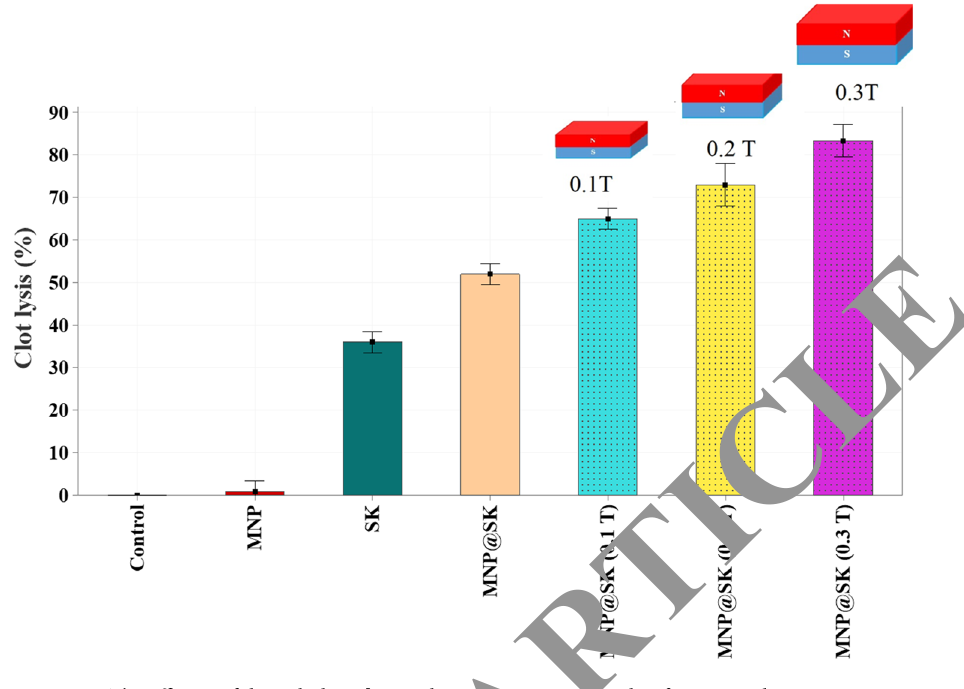
Figure 6. The efficacy of thrombolysis [control, magnetic nanoparticles, free streptokinase, MNP@ SiO 2 + SK + magnet (0.1 to 0.3 T), (error bars indicate standard deviation p <